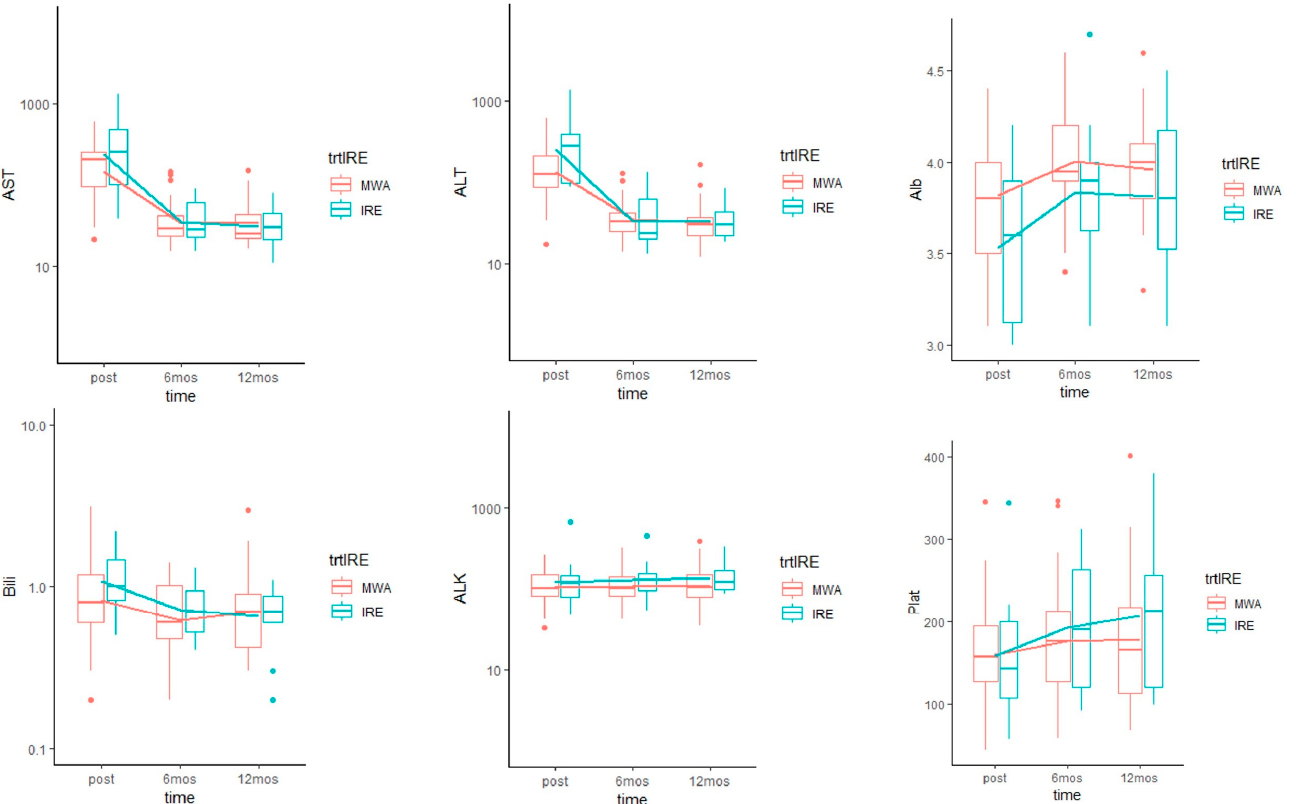
Figure 3. Evolution of laboratory values over time by IRE vs. MWA group. Boxplots with overlaid line graph of means of different laboratory values at each time point. Immediately after procedures, there was an increase in total bilirubin (Bili, Normal (N) < 1.2 mg/dL), alanine transaminase (ALT, N < 33 U/L), aspartate transaminase (AST, N < 37 U/L), and a decrease in albumin (Alb, N: 3.8–5 g/dL) and platelets count (Plat, N: 160–400 K/mcL). Alkaline phosphatase (ALK, N < 120 U/L) remained stable. All values returned to baseline by the 6- and 12-months follow-up in both cohorts. The trajectory of all of the laboratory values did not differ significantly overtime between IRE and MWA.